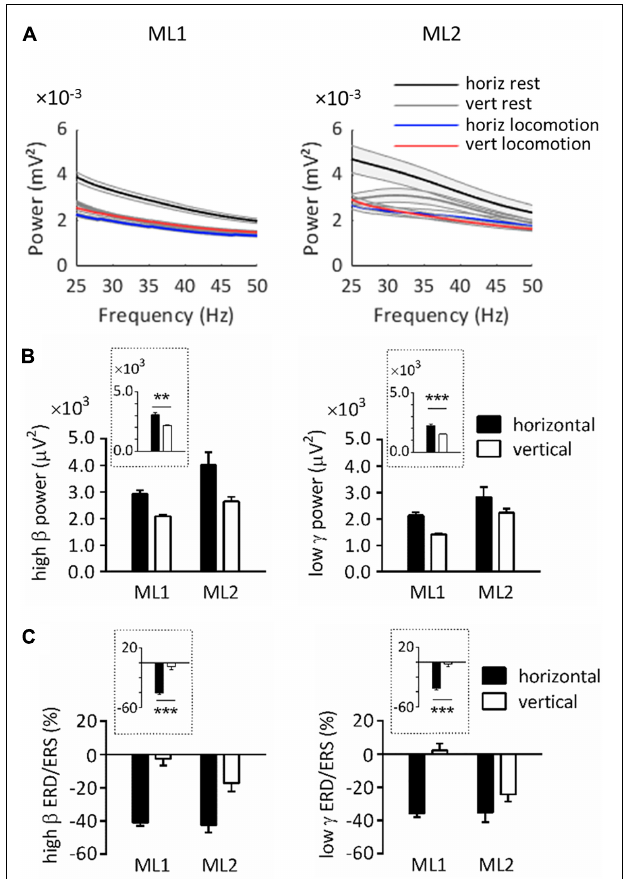
FIGURE 2 | Spectral power over left primary motor cortex in horizontal and vertical conditions. (A) Power spectrum obtained for ML1 and ML2 during horizontal/vertical rest and locomotion. The shaded zone represents one standard error of the mean. (B) High β and low γ power at rest, across animals and substrate orientations. (C) High β and low γ ERD/ERS during locomotion, across animals and substrate orientations. Plots surrounded by a dot line emphasize orientation-related differences averaged across animals. All measurements are expressed as mean ± standard error of the mean (SEM). ** p < 0.01 and *** p < 0.001, main effect of orientation as revealed by two-way ANOVAs with aligned rank transform (factors: animal, orientation). horiz, horizontal; vert,